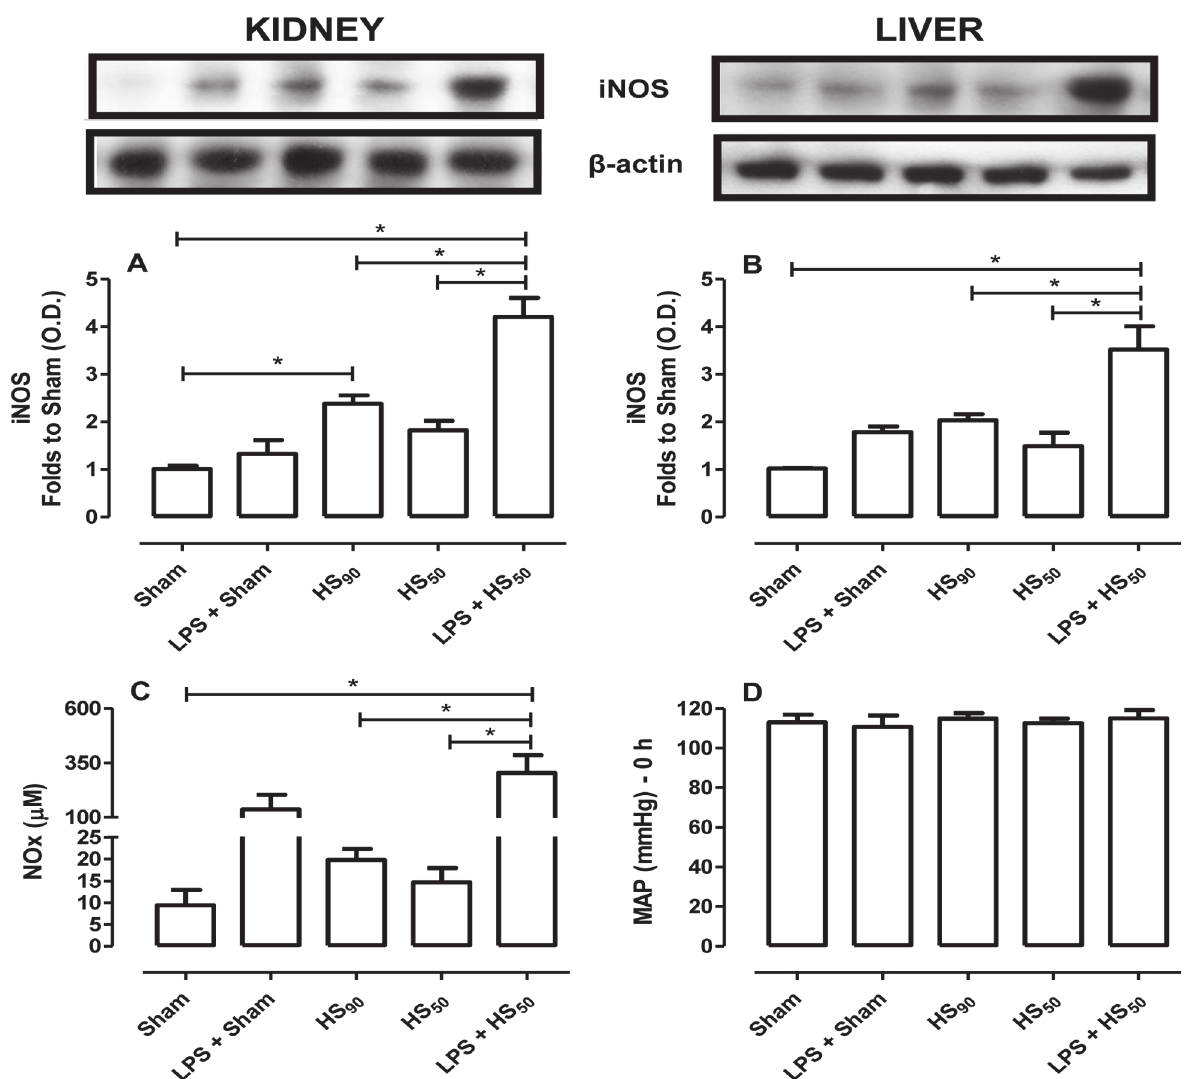
Fig 4. Effect of LPS preconditioning on iNOS expression and serum nitrite and nitrate (NOx). Rats were injected vehicle (PBS) or LPS (1 mg/kg) i.p. 24 h prior to HS 90 or HS 50 . The iNOS expression on the kidney (A) and liver (B) was determined by western blotting. Protein expression was measured as relative optical density (O.D.), corrected for the corresponding β -actin contents and normalized with the Sham band. (C) The concentration of serum NOx was measured as described at Methods. (D) The basal mean arterial pressure (MAP) of all groups is shown. Data are expressed as mean ± SEM of n observations. Statistical analysis was performed using one-way ANOVA followed by Bonferroni ’ s post hoc test. * p < 0.05 among the groups.